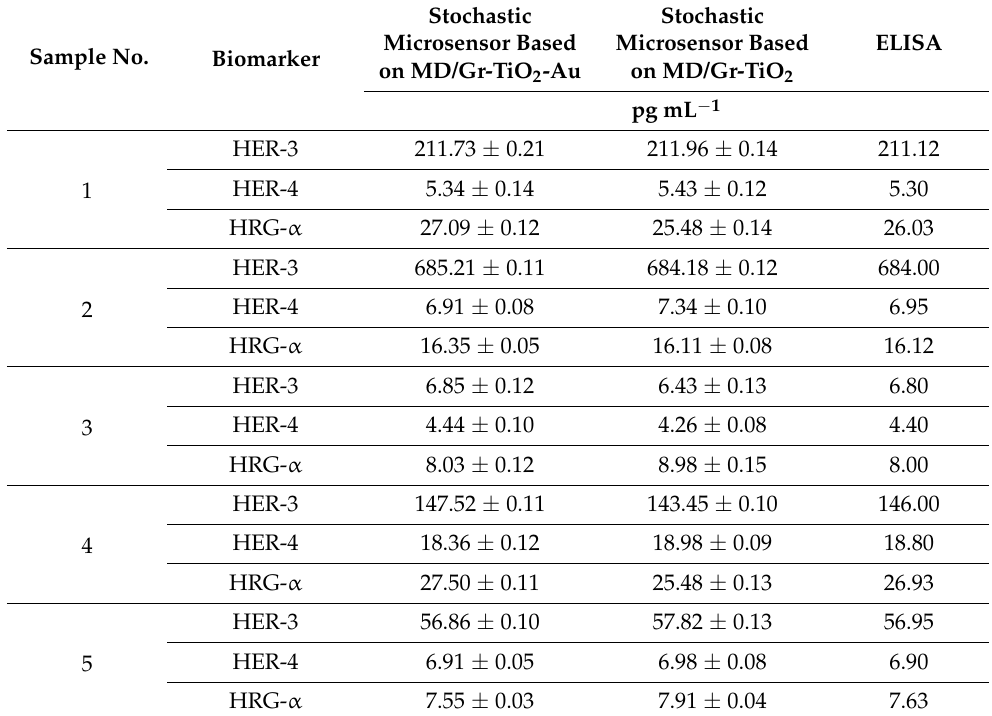
Table 4. Determination of HER-3, HER-4 and HRG- α in tissue samples.